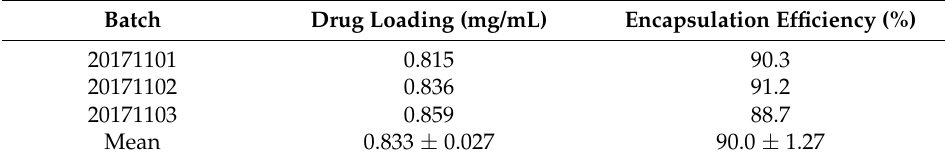
Table 7. Drug loading and encapsulation efficiency of imperatorin lipid microspheres ( x ± s , n = 3).